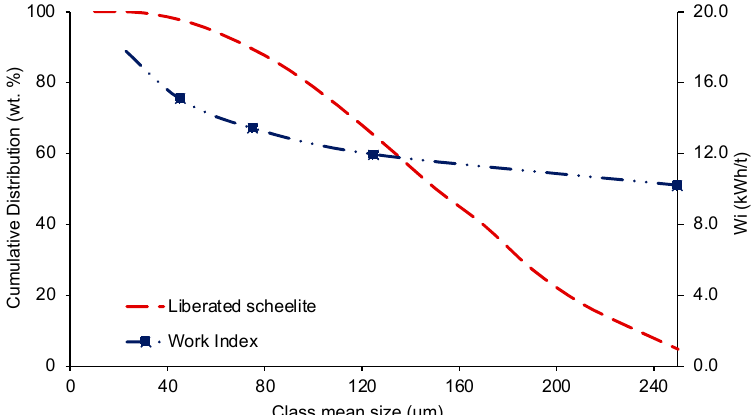
Figure 7. Dependence of the work index on the cumulative distribution of scheelite content in the material.